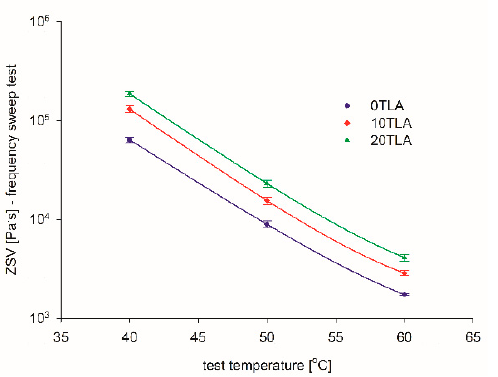
Figure 10. ZSV from the Cross model versus test temperature and TLA content on a semi-log plot.